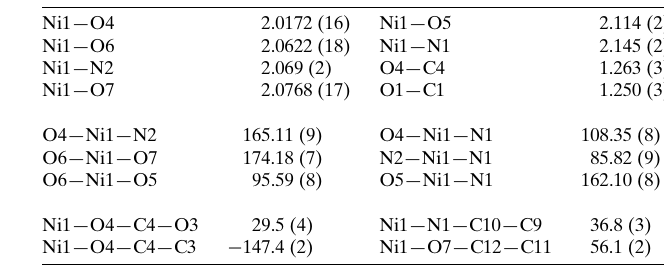
Table 1 Selected geometric parameters (A˚ , (cid:4) ).